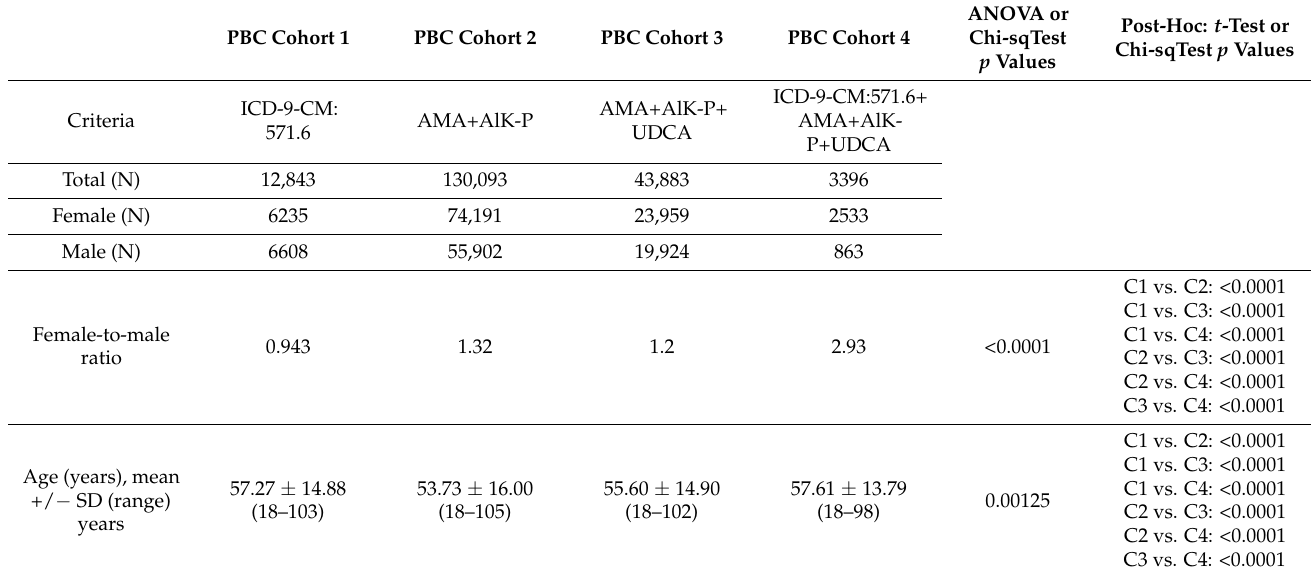
Figure 1. A schematic flowchart of patient enrollment. PBC: primary biliary cholangitis;ICD-9-CM: International Classification of Disease, Ninth Revision, Clinical Modification; AMA: antimitochondrial antibodies; Alk-P: alkaline phosphatase; UDCA: ursodeoxycholic acid; HBV: hepatitis B virus; HCV: hepatitis C virus; YO: years old. Table 1. Baseline characteristics of the 4 PBC cohorts.